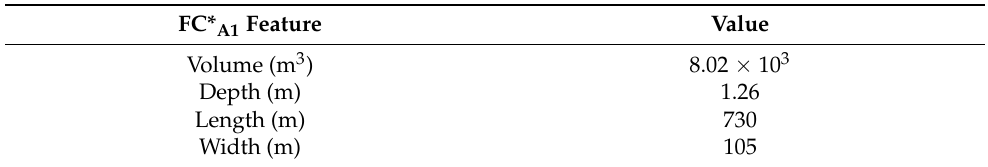
Table 3. Main dimensional features of the vegetated flood control area FC* A1 : volume (m 3 ), average depth (m), length (m) and average width (m).